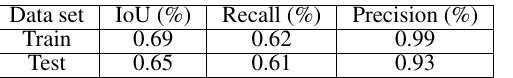
Table 1. Evaluation